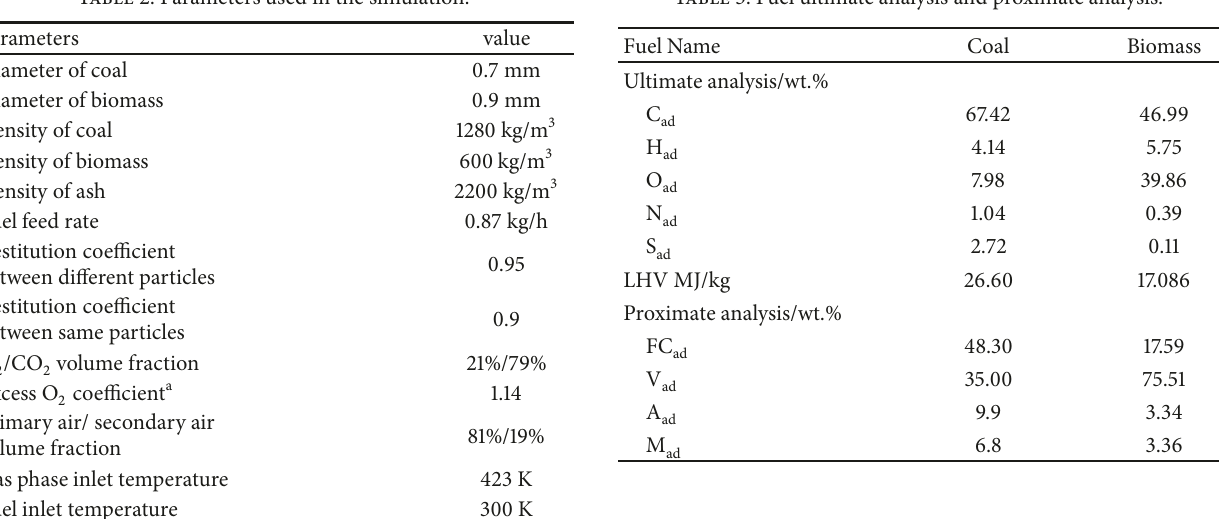
Table 2: Parameters used in the simulation. Table 3: Fuel ultimate analysis and proximate